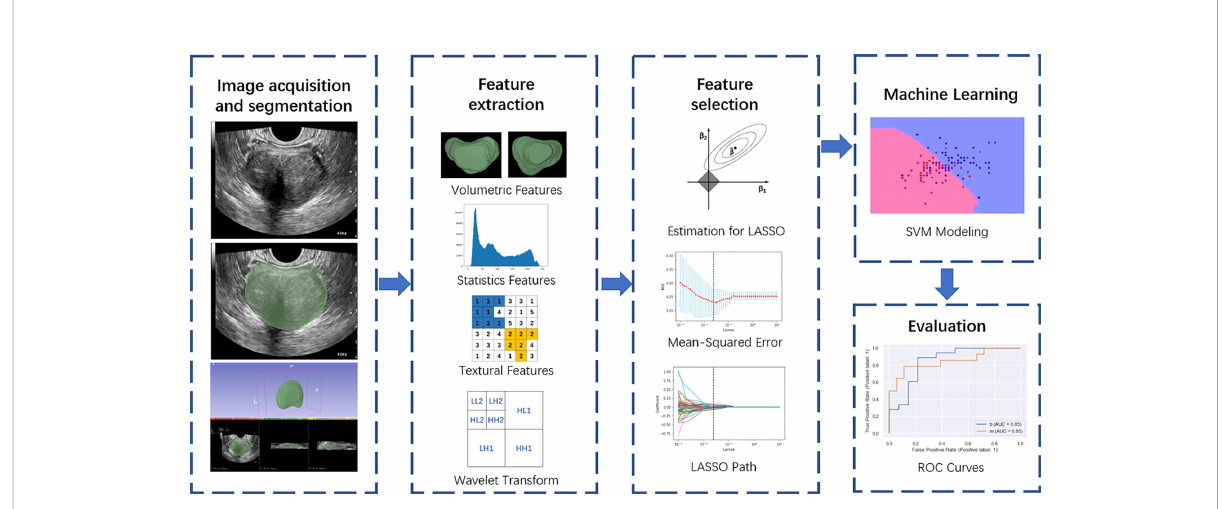
FIGURE 2 Overall fl ow chart ofthe study,including imageacquisition and segmentation, featureextraction, featureselection, machine learning,